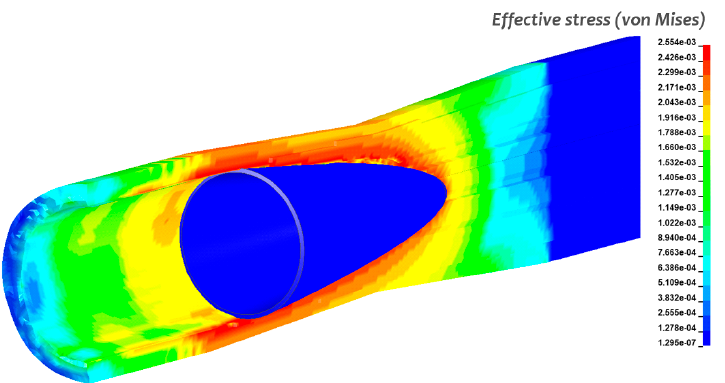
Figure 10. Stress concentration around the plug.